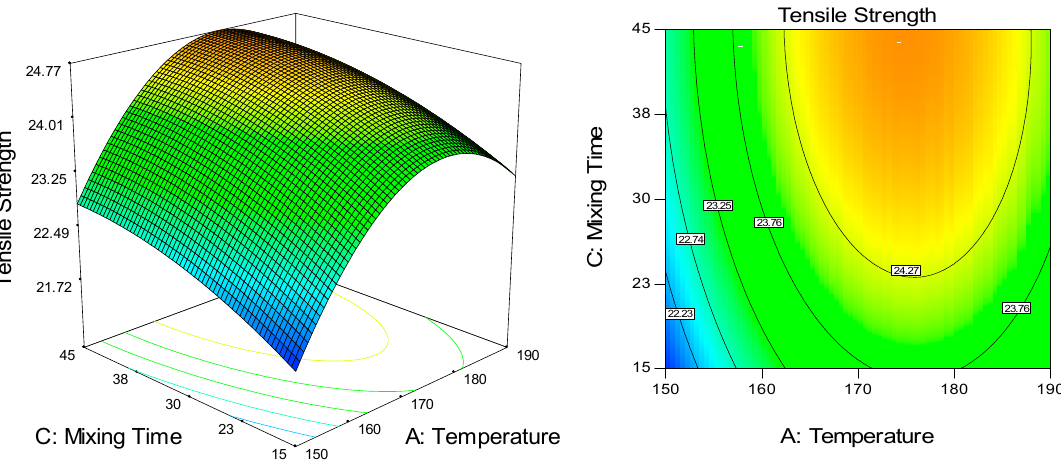
Figure 2. The 3D and contour plot for the dependence of UHMWPE/CNF bionanocomposite’s tensile strength on temperature and mixing time as significant factors.